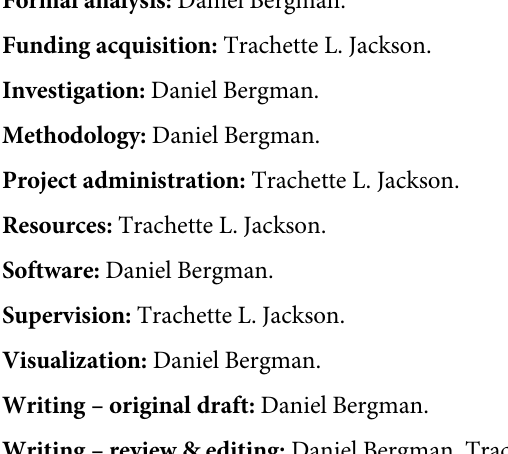
both the local and global methods. Shaded area represents ± 1 SD from the mean. A. Quies- cence modeled as a threshold. B. Quiescence modeled as an event. (TIF) S6 Fig. Comparison of wall times between the two methods when solving the intracellular signaling with MATLAB’s ode45 and every other differential equation as described in Table 2. Simulations were ran until t = 2 min. One sample was run for each method. (TIF) S7 Fig. Comparison of the local and hybrid methods. Compare to Fig 2. (TIF) S8 Fig. Extended results of simulations related to Fig 4. A. Wall time distributions for the two methods. B. Comparison of movements downward (along oxygen gradient) against all movement for both cell types across both methods. Each point represents all movements within one continuous time window in which a agent is in a constant state. C. Heat maps of the four scatter plots shown in B.